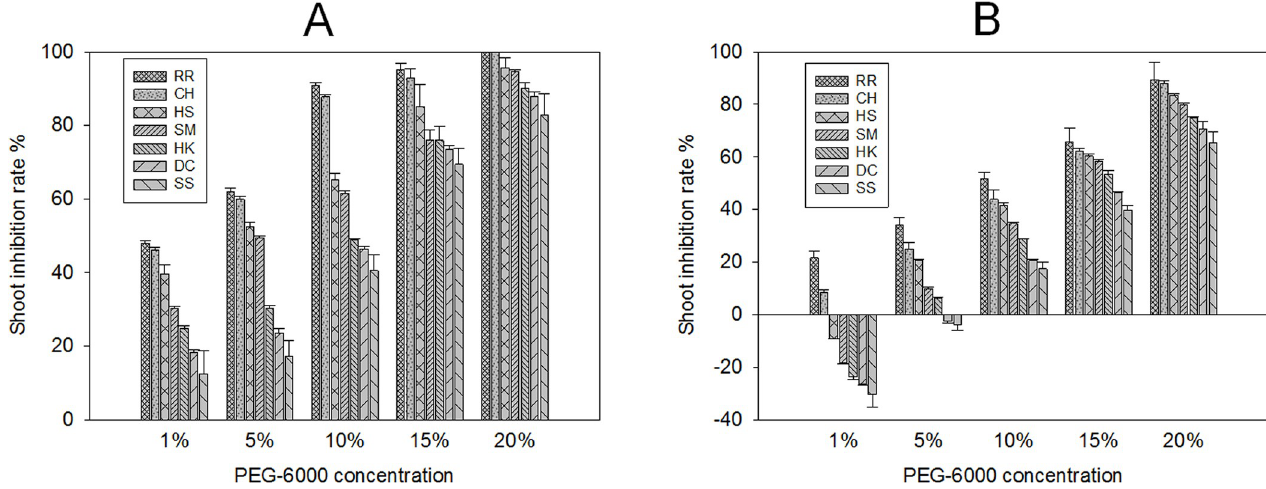
Fig 2. E . crusgalli shoot inhibition rate (%) under five PEG-6000 concentrations at different time periods. E . crusgalli shoot inhibition rate (%) under five PEG-6000 concentrations at 4 days (A) and 7 days (B) of treatment. Data are expressed as least square means ± standard error.